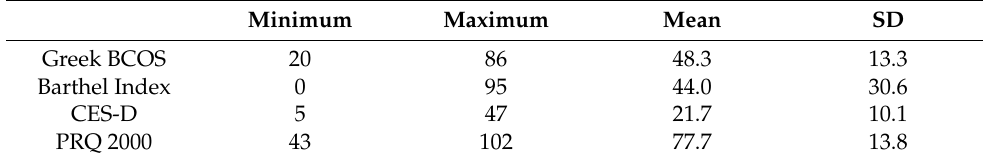
Table 2. Descriptions of study